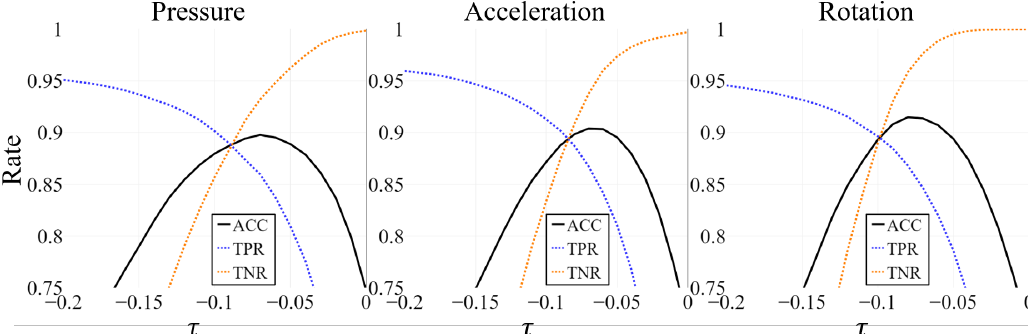
Figure 8. Performance of the uni-modal ensemble model as function of τ for fixed γ = 1.9 and ν =